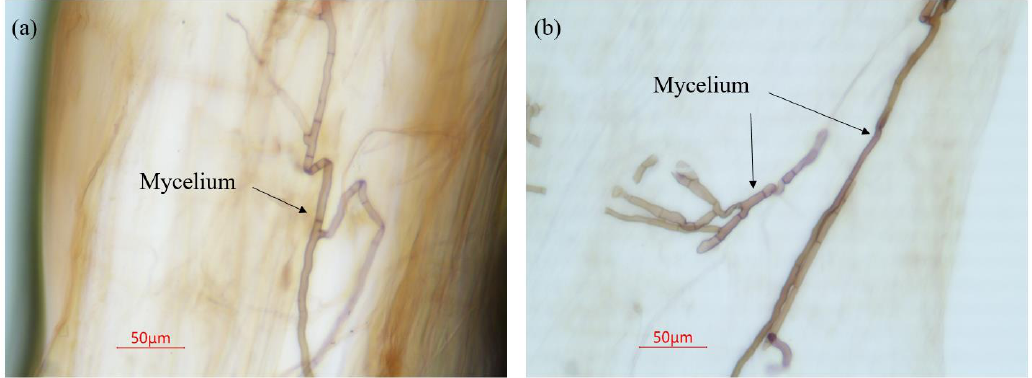
Figure 4. DSE colonization in ( a ) buckwheat and ( b ) alfalfa roots. DSE colonization rates in B-SCK were 15–25% in 2020 and 2021. DSE